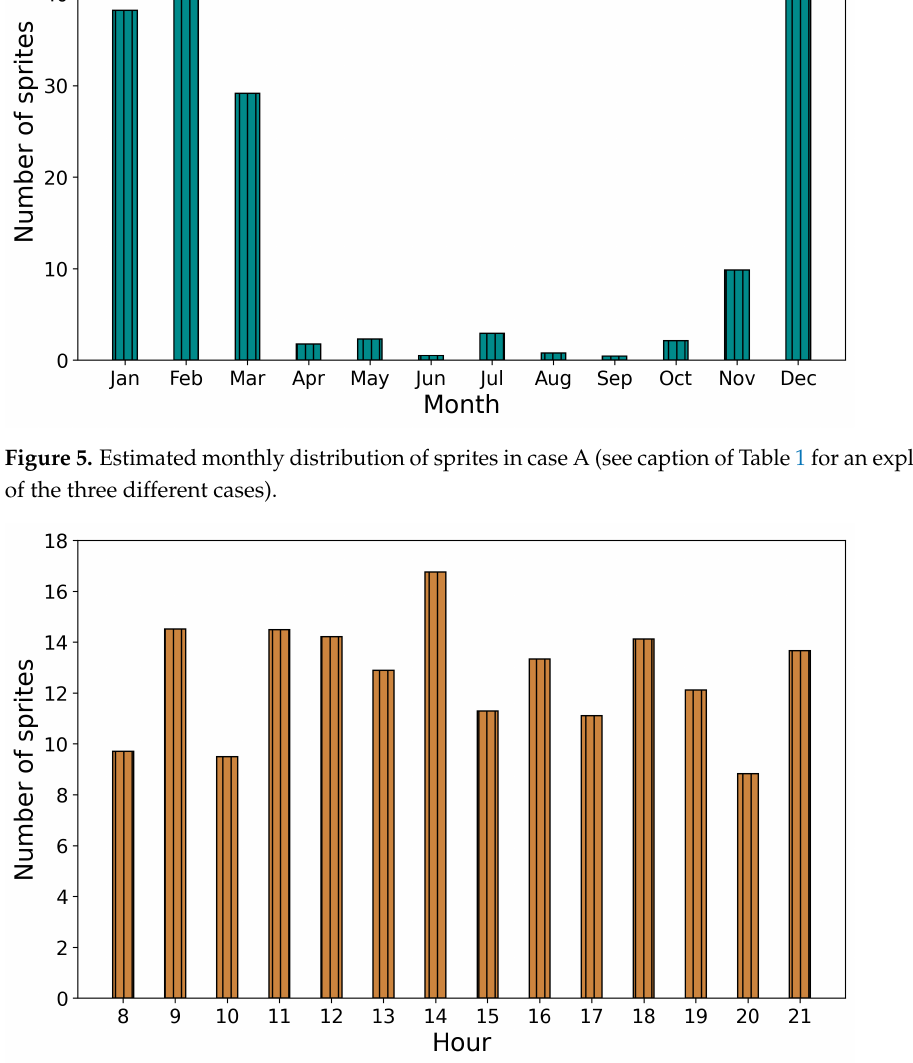
Figure 6. Estimated hourly distribution of sprites in case A (see caption of Table 1 for an explanation of the three different cases). Table 1. Correlation coefficients between the estimated and the observed number of sprites. The − 2022 columns N 2016